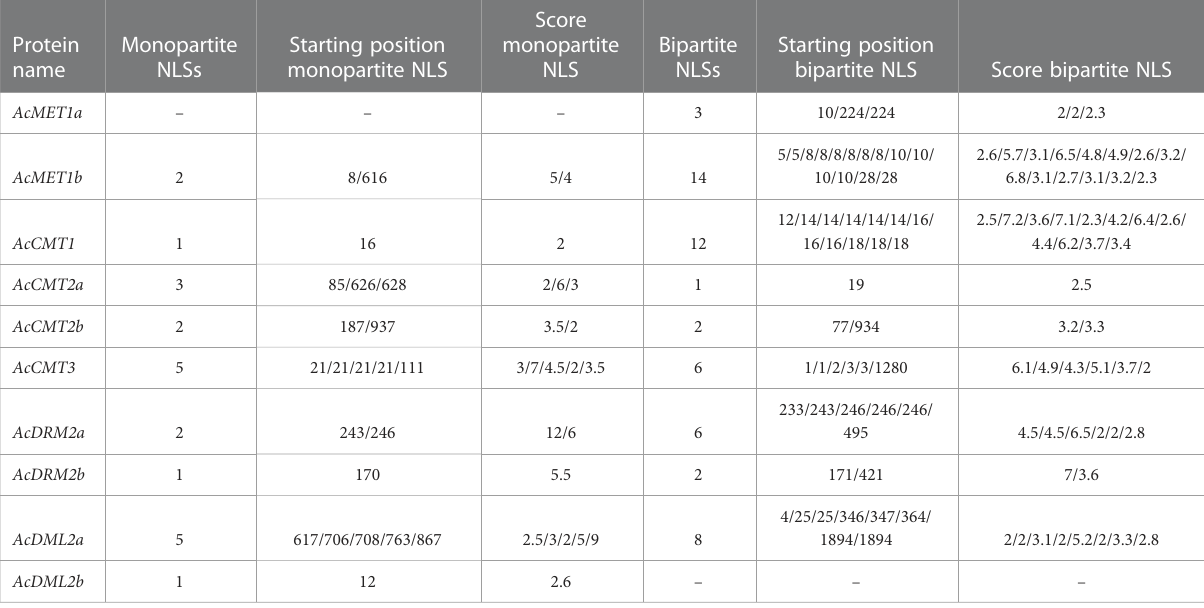
TABLE 3 Prediction of nuclear localization signals for identi fi ed C5-MTase and DMTase proteins in A. cruentus ; cut off score = 2; protein with score >8 is predicted to be localized exclusively in nucleus, score >3 and <8 both the nucleus and the cytoplasm; score <2 localized in the cytoplasm.